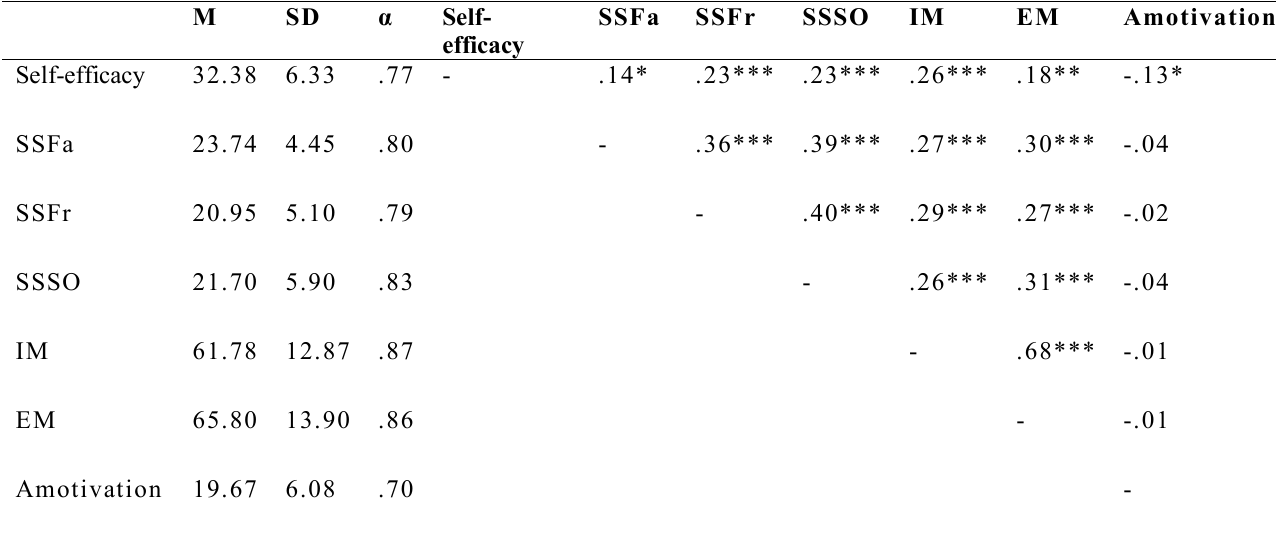
Descriptive Statistics, Alpha Reliabilities, and Correlation Matrix for Study Variables M SD α Self- SSFa SSFr SSSO IM EM Amotivation efficacy Self-efficacy 32.38 6.33 .77